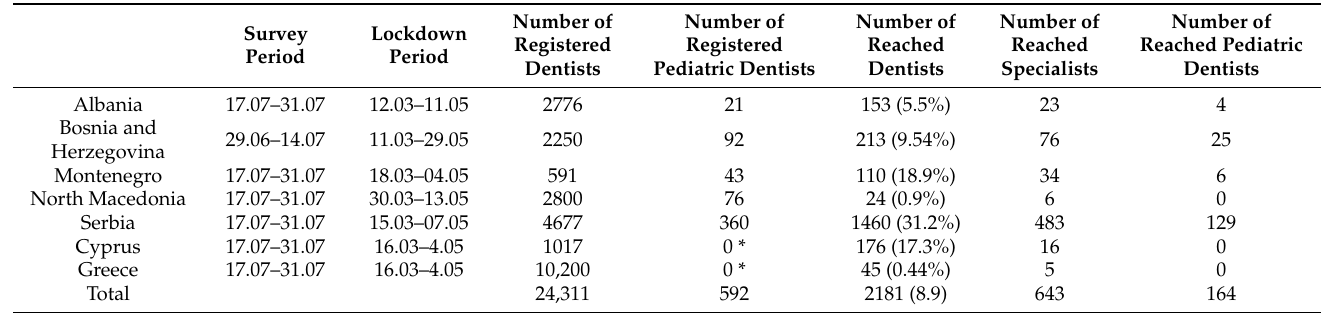
Table 1. Main survey